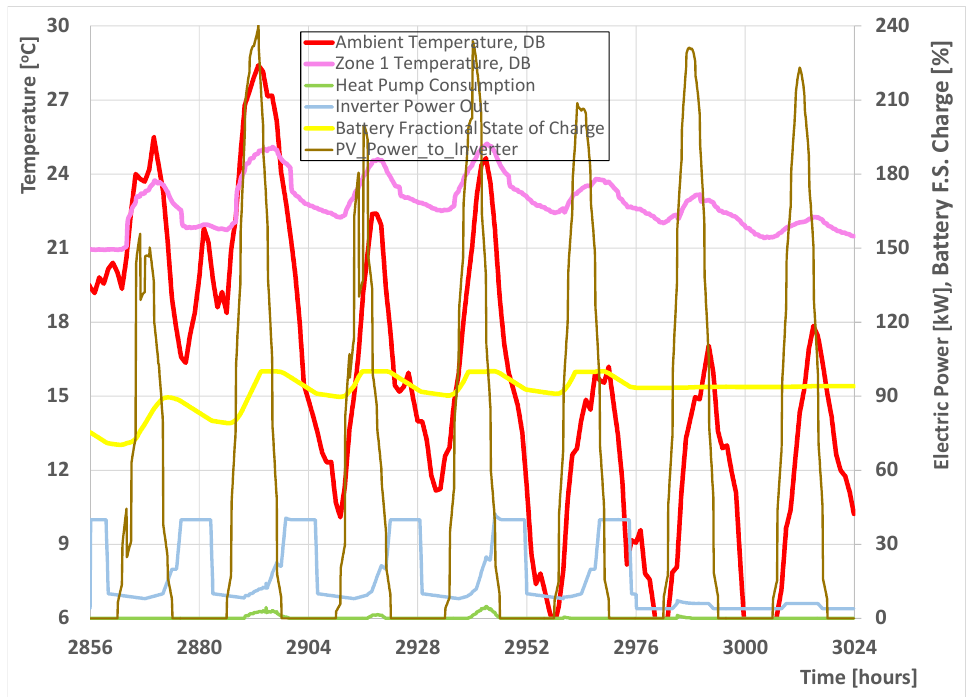
Figure 11. System’s performance during a week in the beginning of May. The temperature set point to 25 °C for the cooling season, however, the heat pump is only slightly necessary. This results in the batteries being charged up to 100% of their capacity.